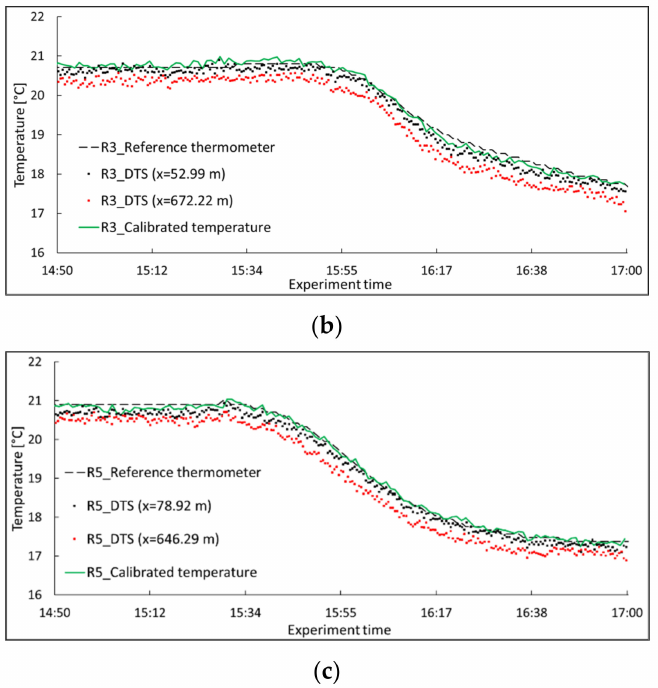
Figure 8. Temperature data for three reference points during the seepage experiment. ( a ) reference point 2, ( b ) reference point 3, and ( c ) reference point 5.